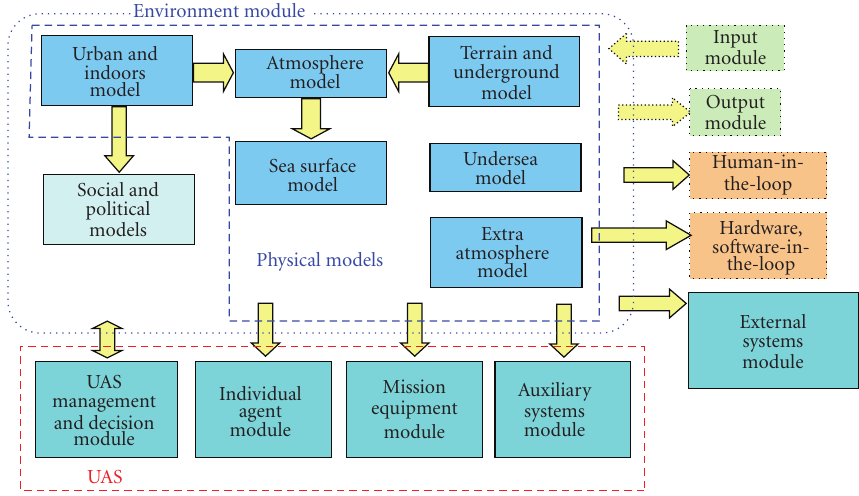
Figure 9: UAS-SE—environment module.